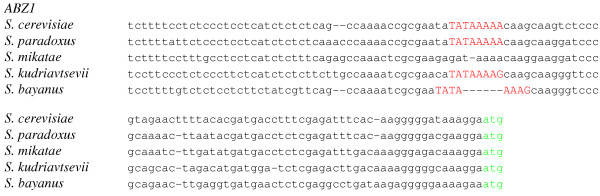
Switch of promoter type by ABZ1 gene. Red, TATA consensus sequence; green, ATG start codon. S. cerevisiae carries the consensus TATA(T/A)A(T/A)(T/G) sequence in position -73 relative to the ATG start codon. The consensus is also conserved in S. paradoxus, S. kudriavtsevii and S. bayanus. In S. mikatae, at least two nucleotides are substituted, eliminating the TATA box.